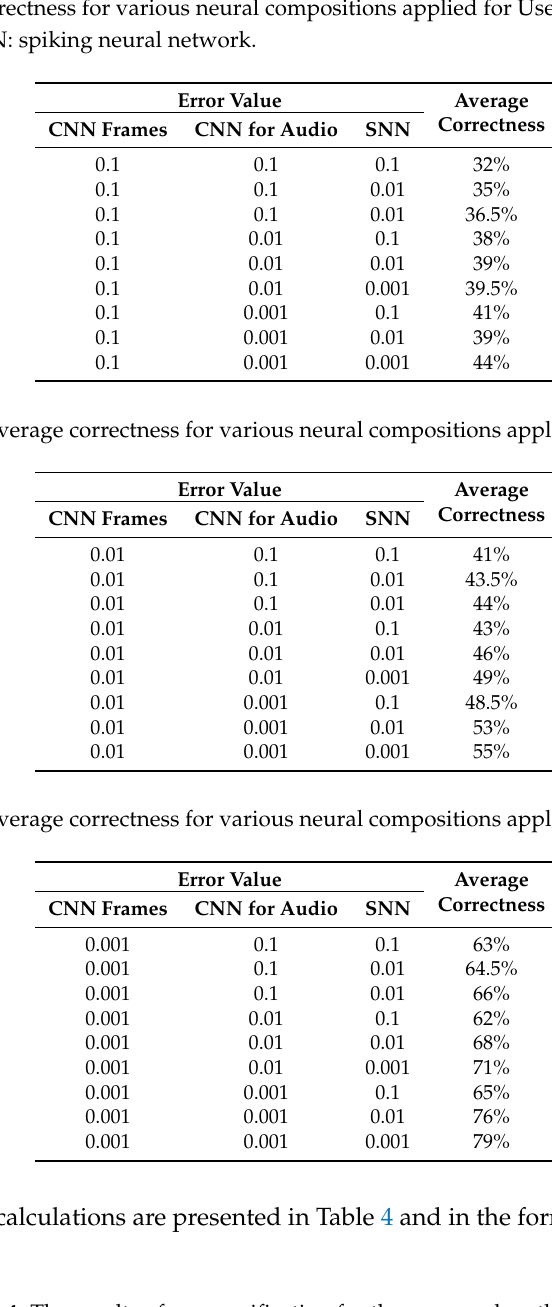
Table 4. The results of user verification for the proposed